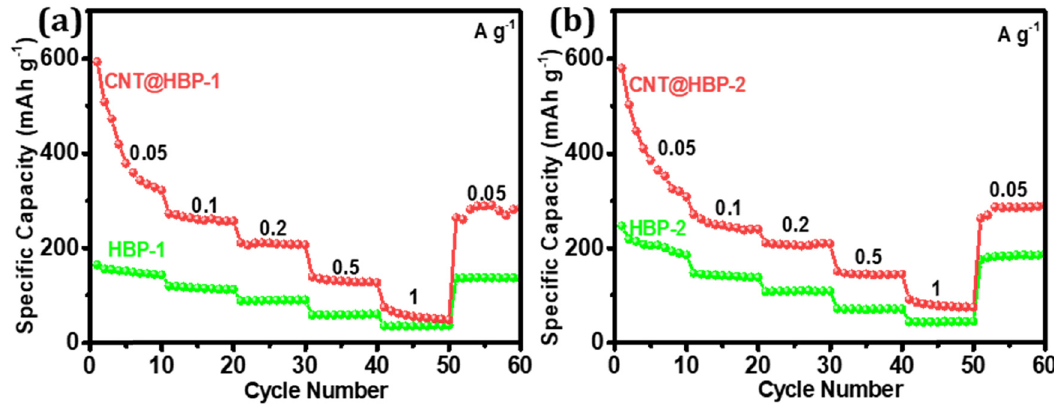
Figure 8: Rate performance of ( a ) HBP - 1 and CNT@HBP - 1 and ( b ) HBP - 2 and CNT@HBP - 2 at di ff erent current